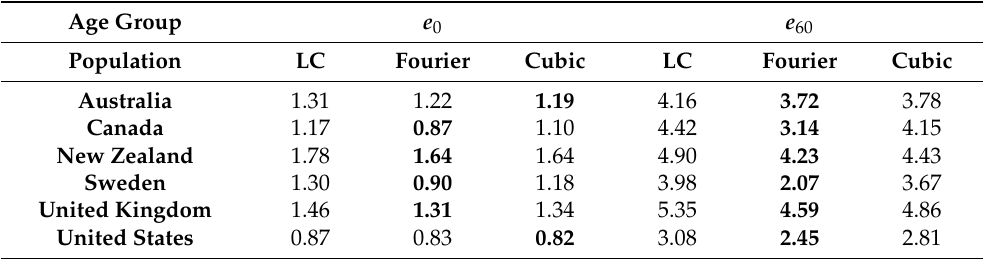
Table 2. MAPE values (%) of projected life expectancies at ages 0 and 60 (rolling-window basis). The minimum MAPE values for each age and each country are given in